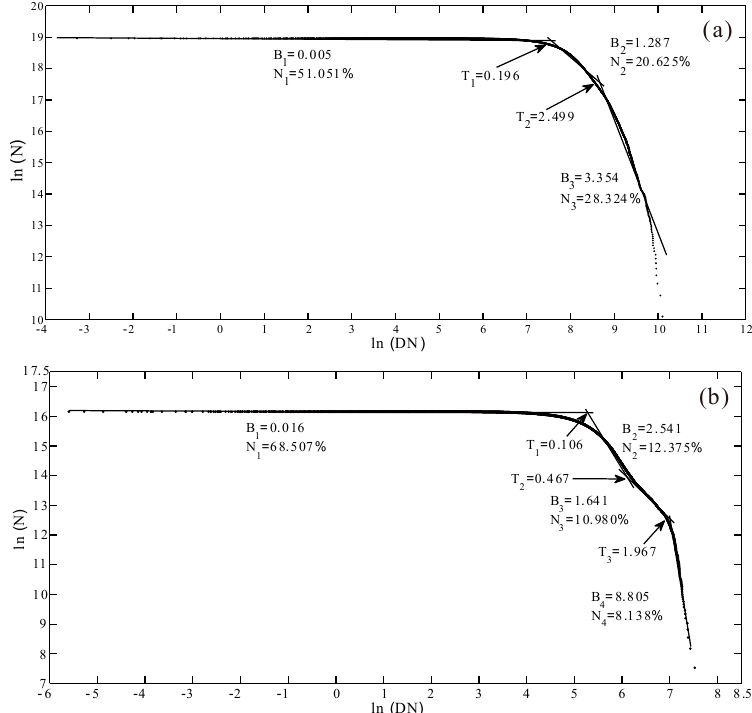
Figure 4. Fractal schema for ln(DN) versus ln(N) of ( a ) region of interest (ROI) 1 and ( b ) ROI 2; B i ( i = 1, 2, 3...) represents a fractal dimension of each segment, N i ( i = 1, 2, 3...) means the pixel size and frequency of a certain DN threshold, and T i ( i = 1, 2, 3...) represents the DN value. The non-scaling interval in Figure 4 corresponds to approximately one ground target.